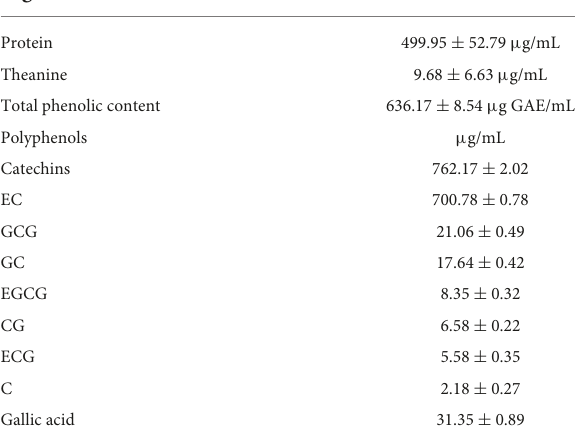
TABLE 2 Main compositions of oolong tea.